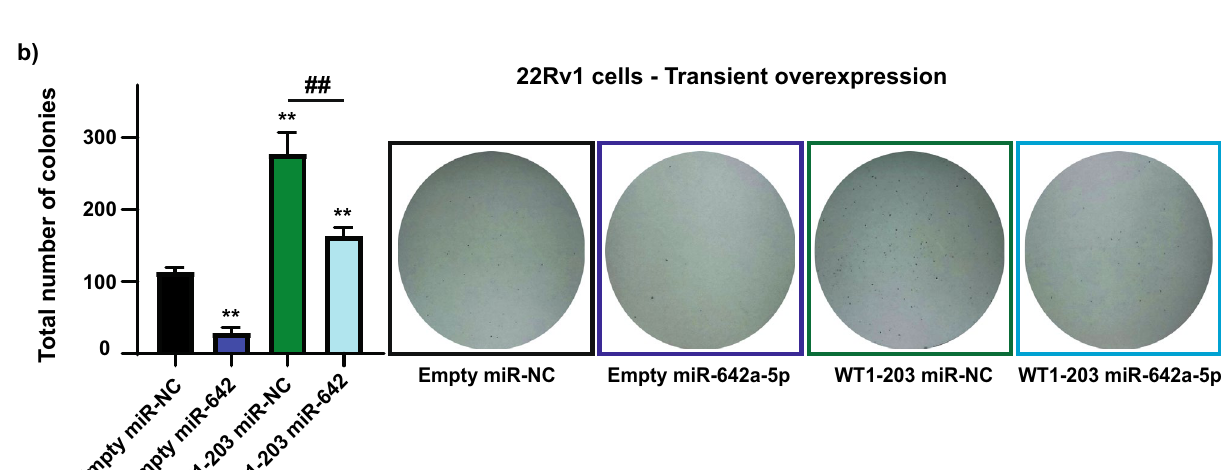
miR-642a-5p action. Cyclin-dependent kinases (CDKs) are critical enzymes that promote transition through the cell cycle and hence the targeting of these in proliferating cancer cells has been the basis for development and clinical application of novel anticancer therapies 43–45 . The CDK inhibitors p21 and p53 are known tumor suppressors and play key roles in regulating transition of cells through the cell cycle 46 . Our data showing their upregulation following miR-642a-5p overexpression also support the role of miR-642a-5p as a tumor suppres- sor in PCa. Interestingly, miR-642a-5p’s ability to reduce cell viability of PCa cells is not reliant on cellular p53 status, as our previous study using other PCa cell subtypes which harbour non-functional p53 (e.g. DU145) also showed a reduction in cell viability with miR-642a-5p overexpression 25,30 . Wilms Tumor 1 (WT1) gene is a member of the early growth response gene I (EGR-1) family of zinc finger transcription factors, having an important role in the normal development of the genitourinary system and other